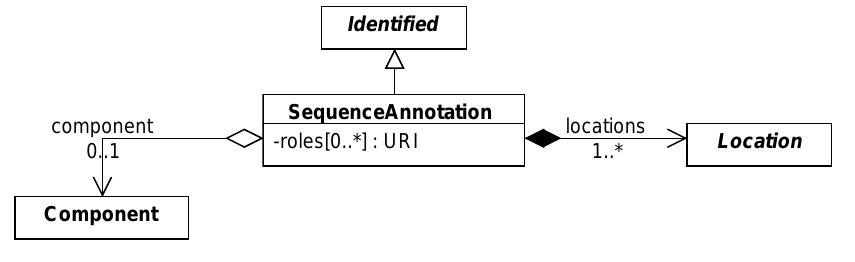
Figure 11: Diagram of the SequenceAnnotation class and its associated